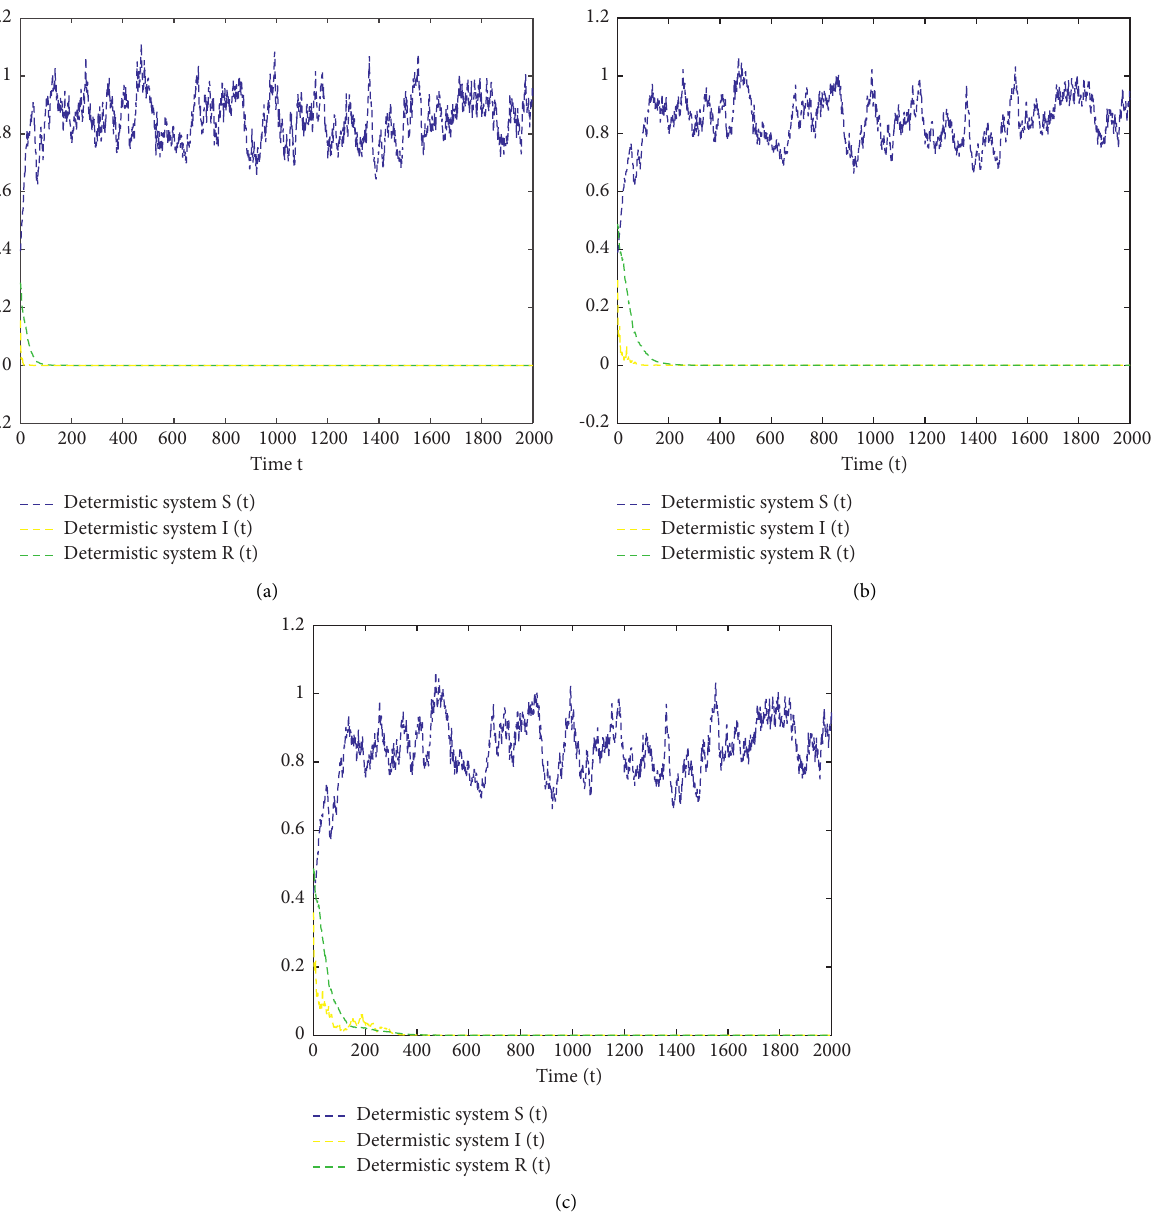
Figure 1: The subgraphs (a)–(c) denote the numerical simulation of conditions ( A ) and ( B ) of Theorem 2 and Corollary 1,